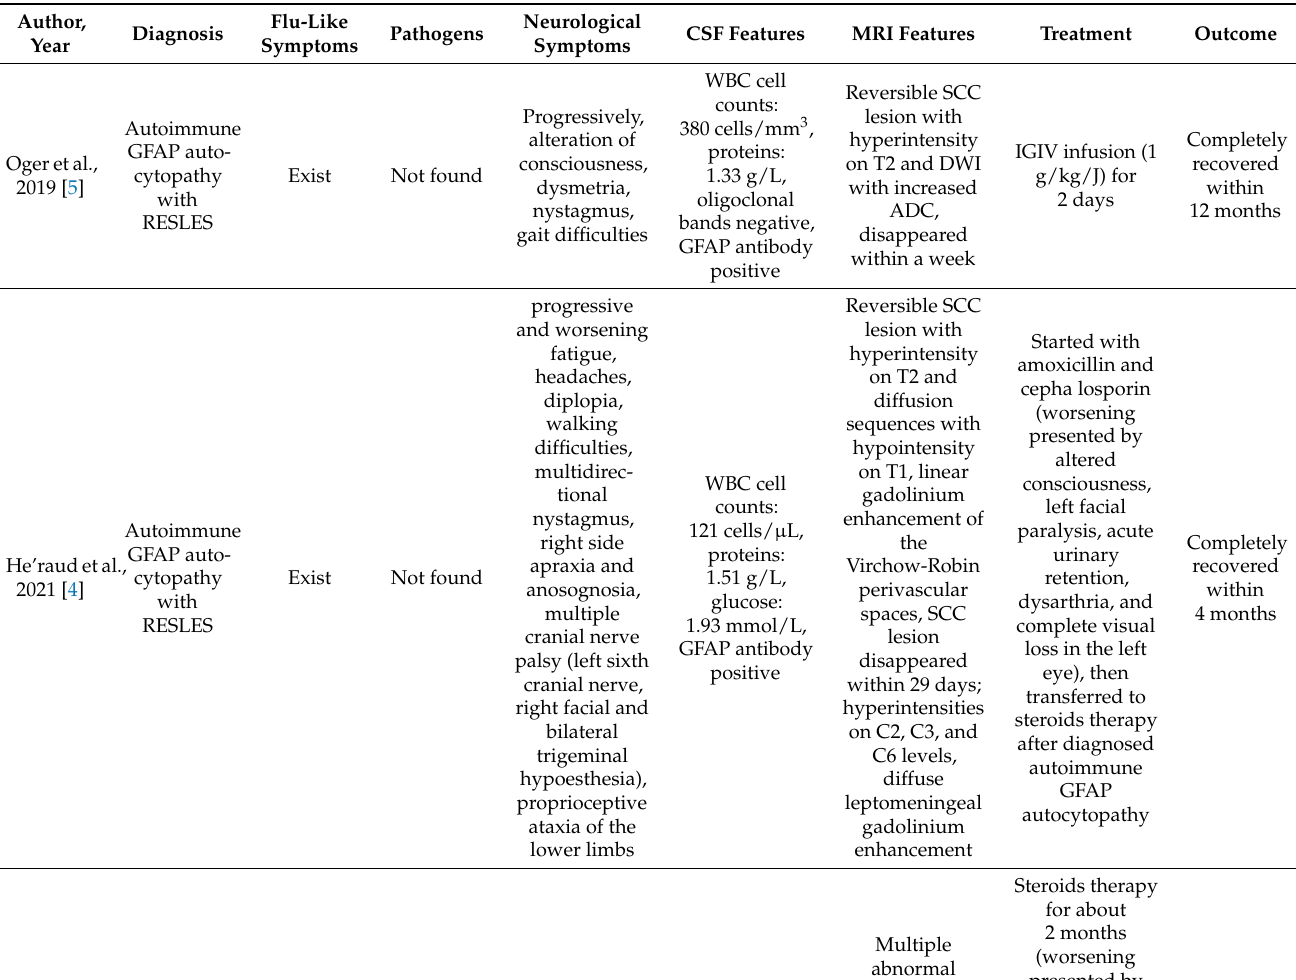
Table 2. Review of published cases of autoimmune GFAP autocytopathy coexist with